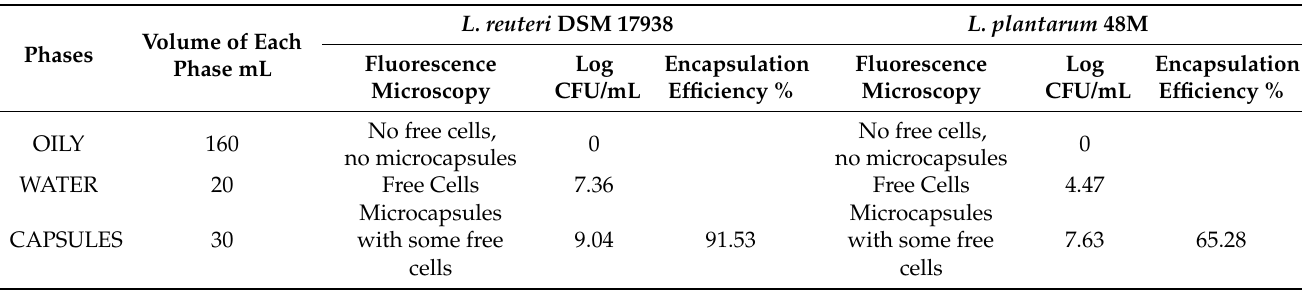
Table 1. Microencapsulation data of L. reuteri DSM 17938 and L. plantarum 48M. The CFU/mL are adjusted to 100 mL (see Section 2.4).